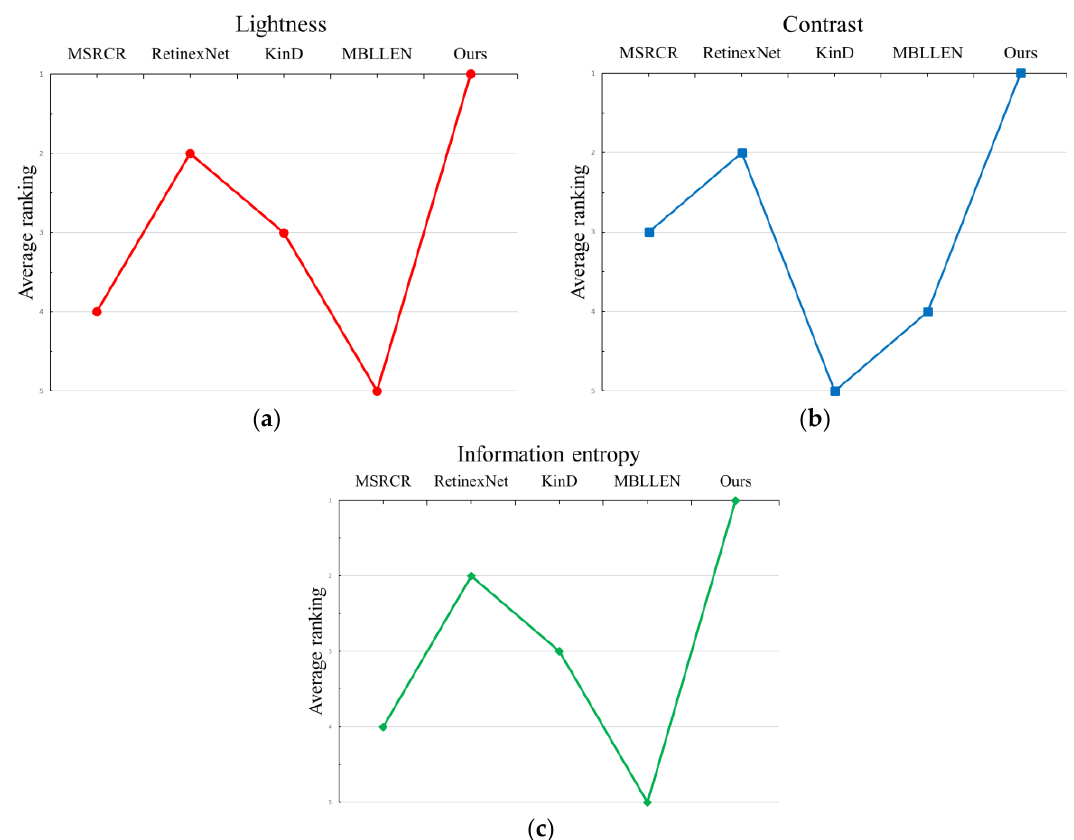
Figure 9. Average ranking of the two test sets, namely general and dedicated, on lightness, contrast, and information entropy: ( a ) for lightness ranking; ( b ) for contrast ranking and ( c ) for information entropy ranking.